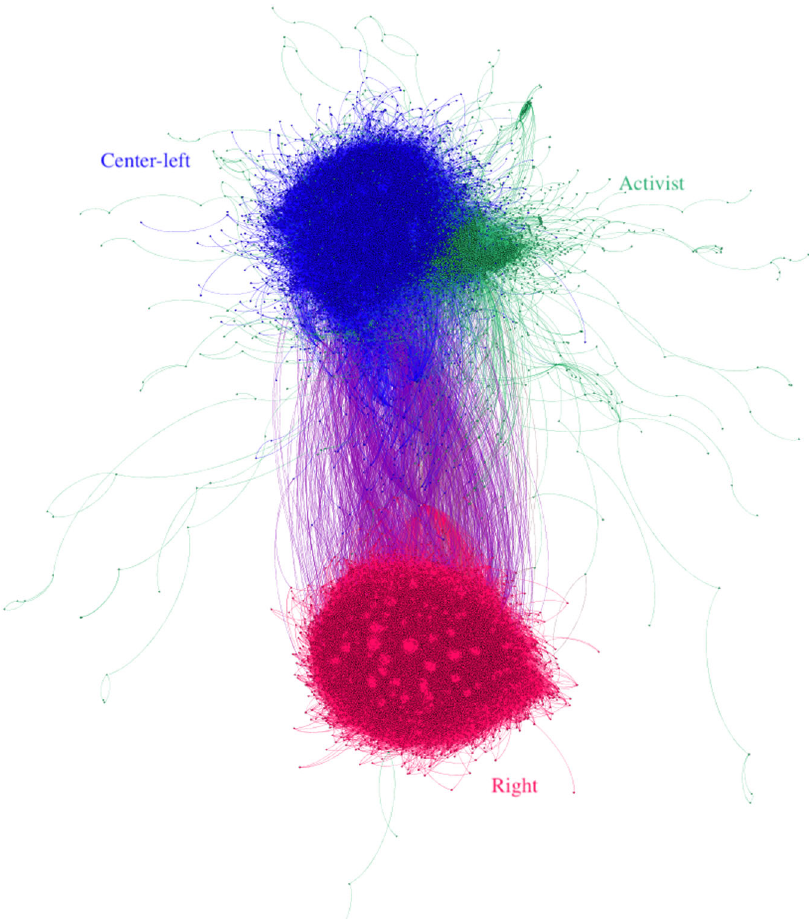
Fig. 1 Retweet graph with groups labeled. Nodes represent authors, edges weighted by number of retweets of one author by the other. Only the top 25% of retweeting nodes in each cluster are shown; apparently solitary pockets are connected to the others in the group on the strength of weak ties here omitted. Layout by Gephi ’ s forceatlas2 algorithm.